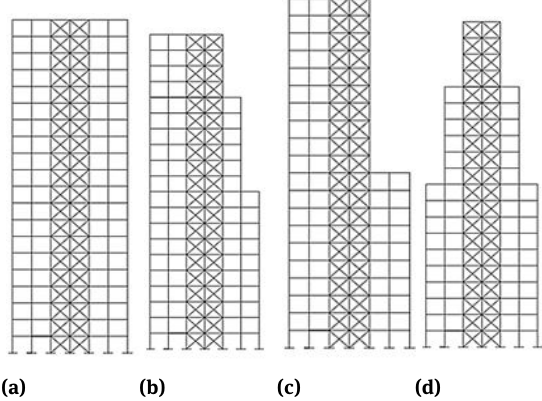
Figure 2: View of regular and irregular models in height for a 20- storey model, (a) Regular model; (b) Irregular model of case 1; (c) Irregular model of case 2; (d) Irregular model of case